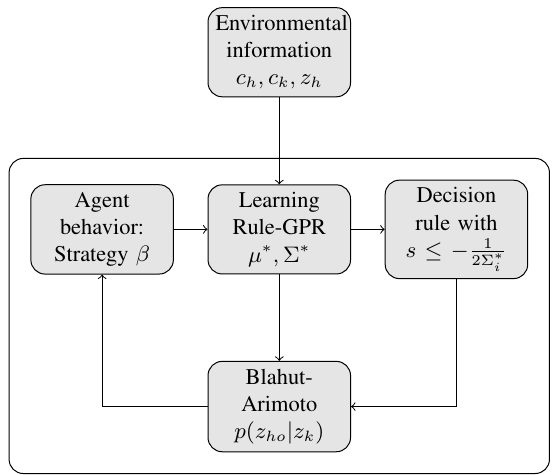
Fig. 5. Proposed multi-agent learning framework.